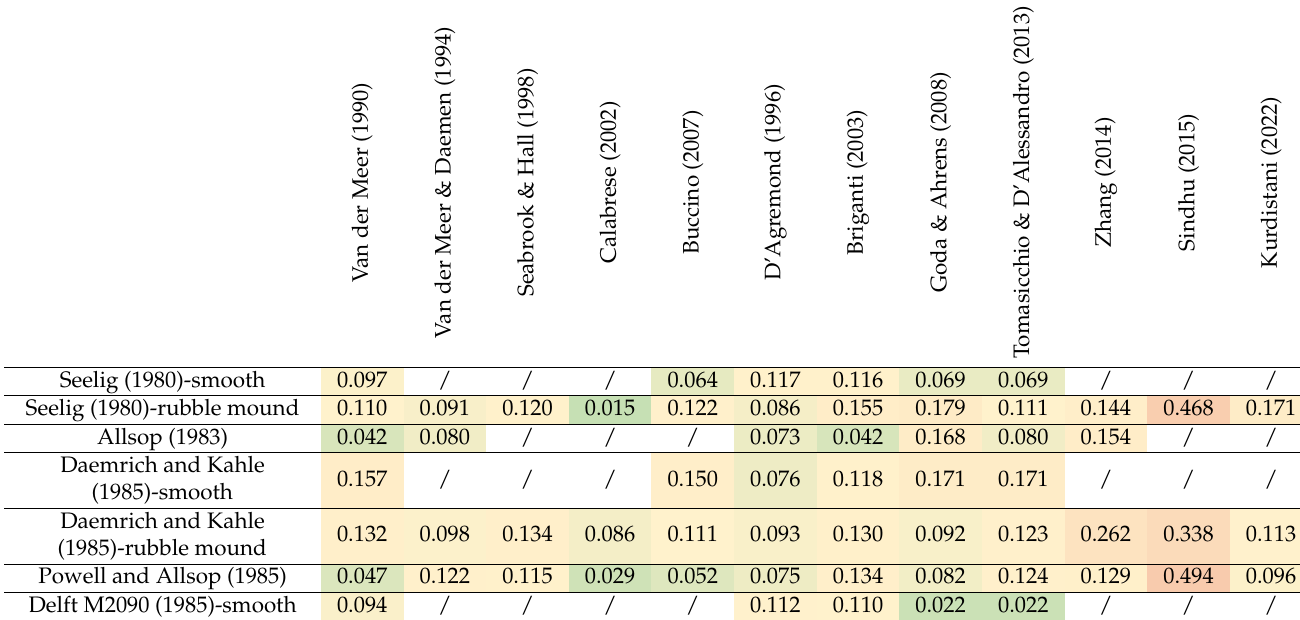
Table 6. RMSE of each formula for single dataset and mean value for each